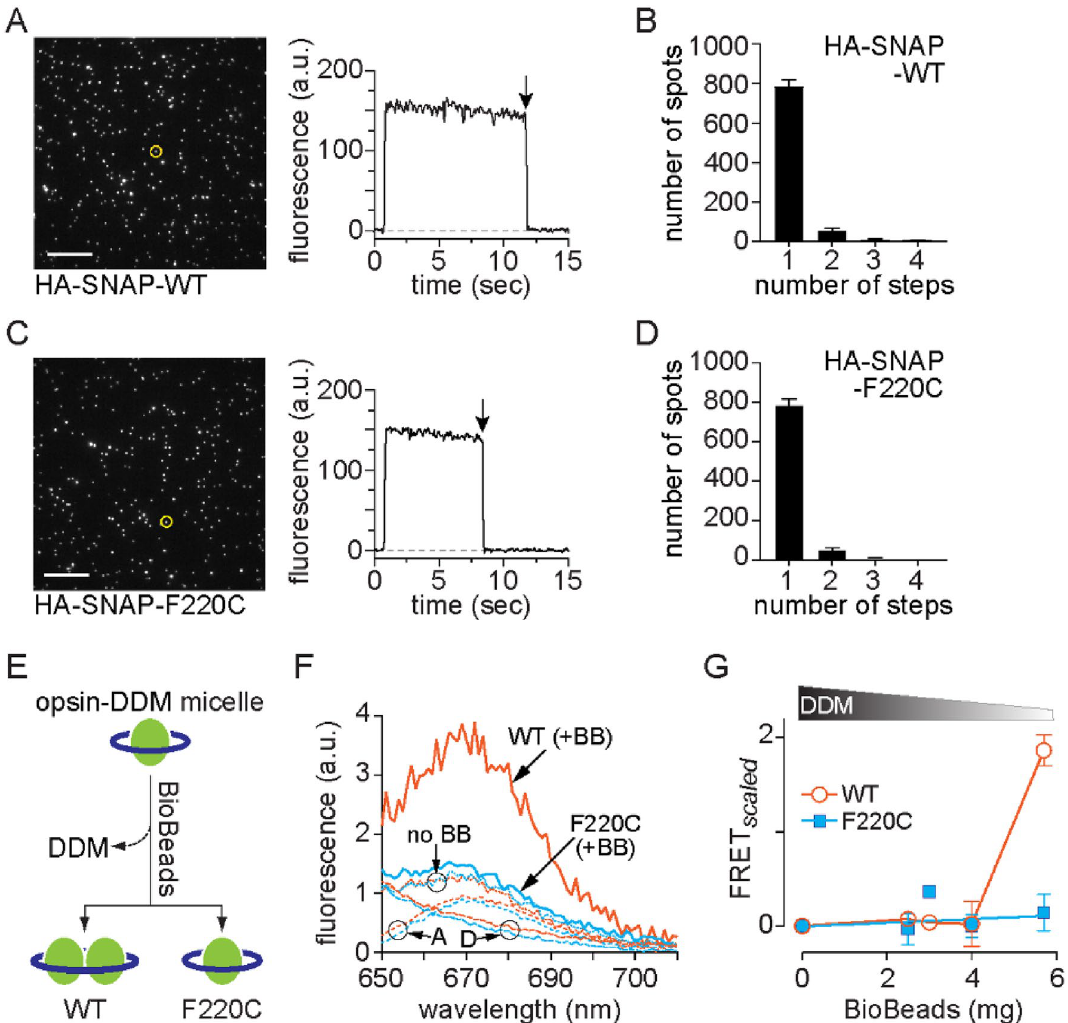
Figure 1. Dimerization of WT opsin, but not F220C opsin, in a micellar system. (A–D) SiMPull experiments with HA-SNAP-WT opsin (A,B) and HA-SNAP-F220C opsin (C,D) . Opsin constructs were expressed in HEK293T cells and labeled using a membrane-impermeant SNAP fluorophore (LD555). The cells were solubilized in DDM and the proteins were captured on glass slides coated with anti-HA antibodies for visualization of fluorescence by TIRF microscopy (A,C) . Bleaching of individual spots was recorded; traces for representative spots (circled in the fluorescence images) are shown, with arrows to indicate the bleaching step, and the number of spots that bleached in 1, 2, 3 or 4 steps was quantified (B,D) . We note that as fluorophore bleaching is a stochastic process, the time taken for an individual spot to bleach is arbitrary. (E) Schematic of the effect of detergent removal on the quaternary structure of WT and F220C opsins. (F) Emission spectra (λ ex = 555 nm) for donor (D)-acceptor (A) pairs of WT (orange) or F220C opsin (blue) treated with 5.7 mg Bio-Beads (+ BB, solid lines) or mock-treated (no BB, dotted lines). Spectra of mock treated samples of acceptor alone and donor alone (’A’ and ’D’, dashed lines) are also shown. Sensitized emission of the acceptor (λ ex = 555 nm, λ em = 670 nm) indicates FRET as seen in the BioBead-treated WT sample (+ BB). (G) FRET was quantified after extracting increasing amounts of DDM (shown schematically above the graph) by treating samples with different amounts of Bio-Beads. A FRET measure (FRET scaled ) was obtained by calculating the ratio of the emission intensity at 670 nm for D-A mixtures relative to the acceptor-only sample, followed by an offset correction corresponding to mock-treated samples (no BB, A ). Data are mean ± SEM (n ≥ 3) and connecting lines are drawn to guide the